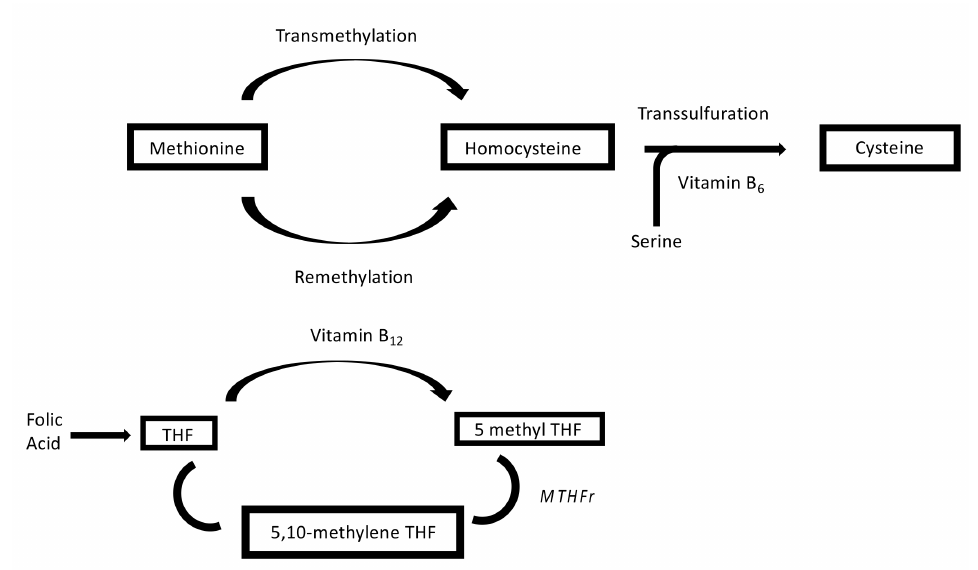
Figure 1. Role of Hcy in folate metabolism. THF: tetrahydrofolate; MTHFR: 5,10-methylene tetrahy- drofolate reductase (gently taken from